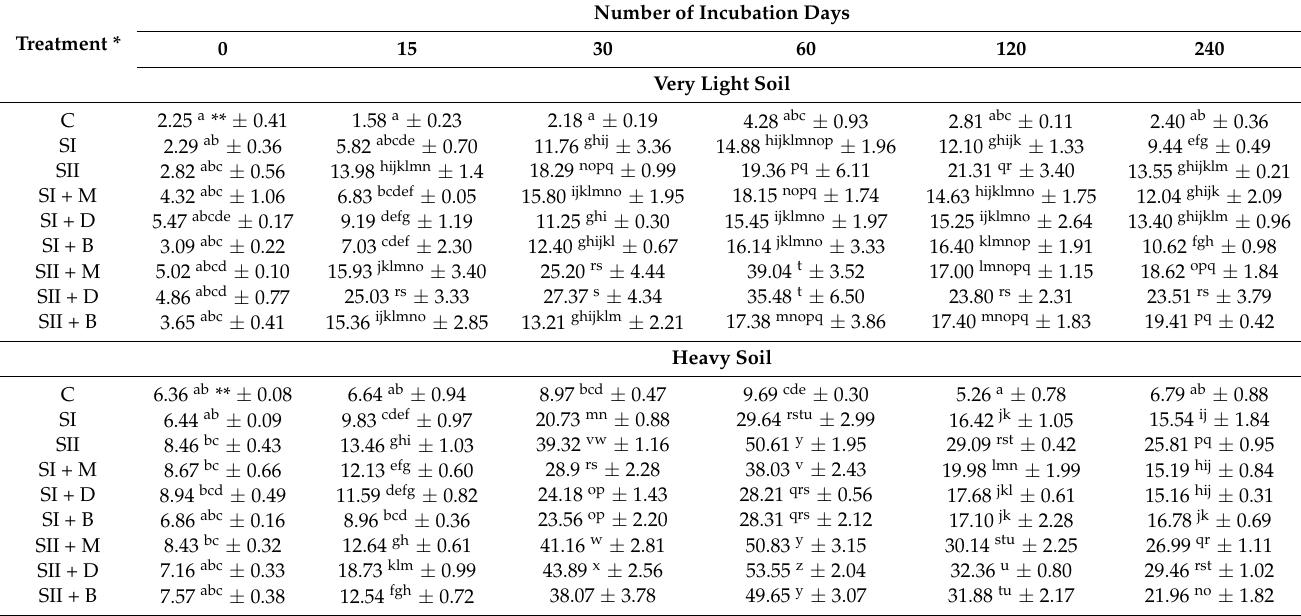
Table 4. Sulfate sulfur content in very light and heavy soil throughout the incubation experiment (mg S/kg d.m. ±